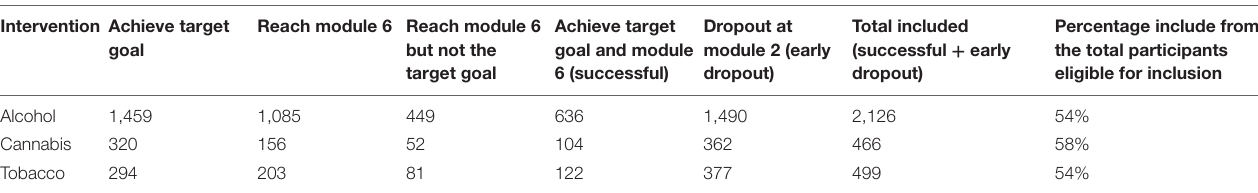
TABLE 1 | Distribution of participants per label definition. Intervention Achieve target